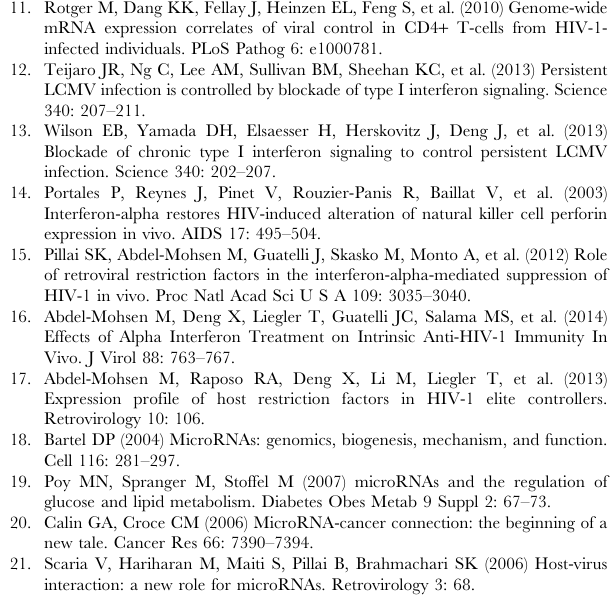
Figure S1 IFN- a /RBV treatment does not alter the expression of microRNA machinery genes in vivo .